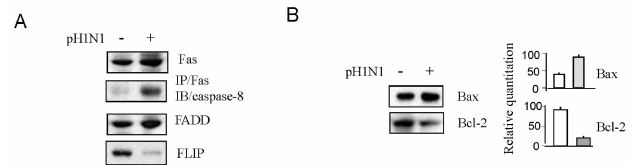
Figure 6. Pandemic influenza A (H1N1) virus infection can activate apoptotic pathways in HIV-1 latent infected cells. J1.1 cells were infected with pH1N1, stock A/California/04/2009, and cultured for 3 days. ( A ) The cell lysates were subjected to Western blot analysis to detect FADD, FAS and FLIP (A), Bax and BCL-2 ( B ). DISC formation was evaluated by IP total lysates with anti-Fas antibody